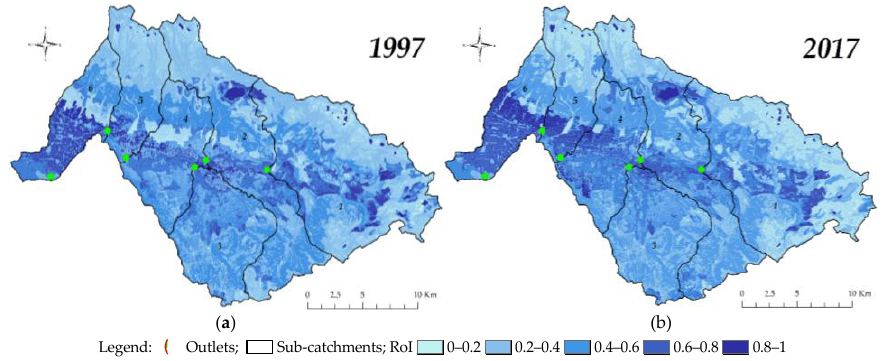
Figure 9. Geographical distribution of the different runoff indicator (RoI) classes in the Rocha River catchment in ( a ) 1997 and ( b ) 2017.